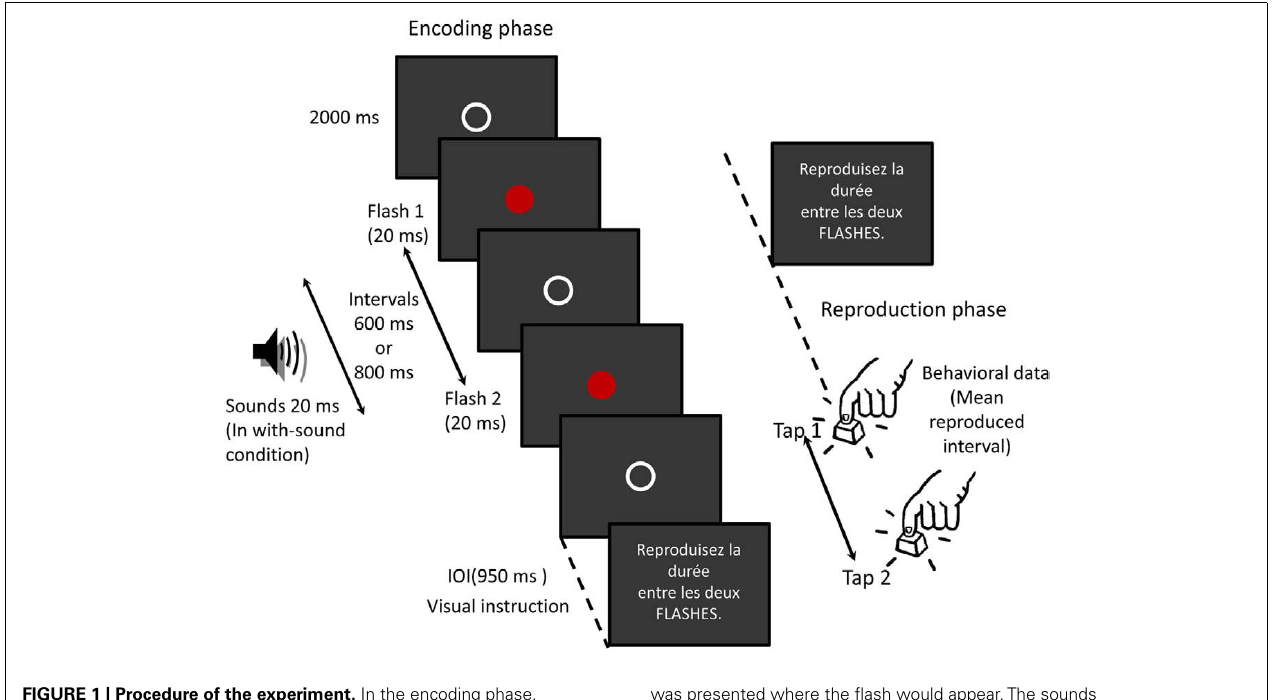
FIGURE 1 | Procedure of the experiment. In the encoding phase, the stimulus epoch begins 100ms prior to the onset of the first flash and continues for 1200ms. During half of the trials within a block, in a random order, series of three auditory stimuli (20ms, 1kHz) were presented. Before and after the flashes, a white circle